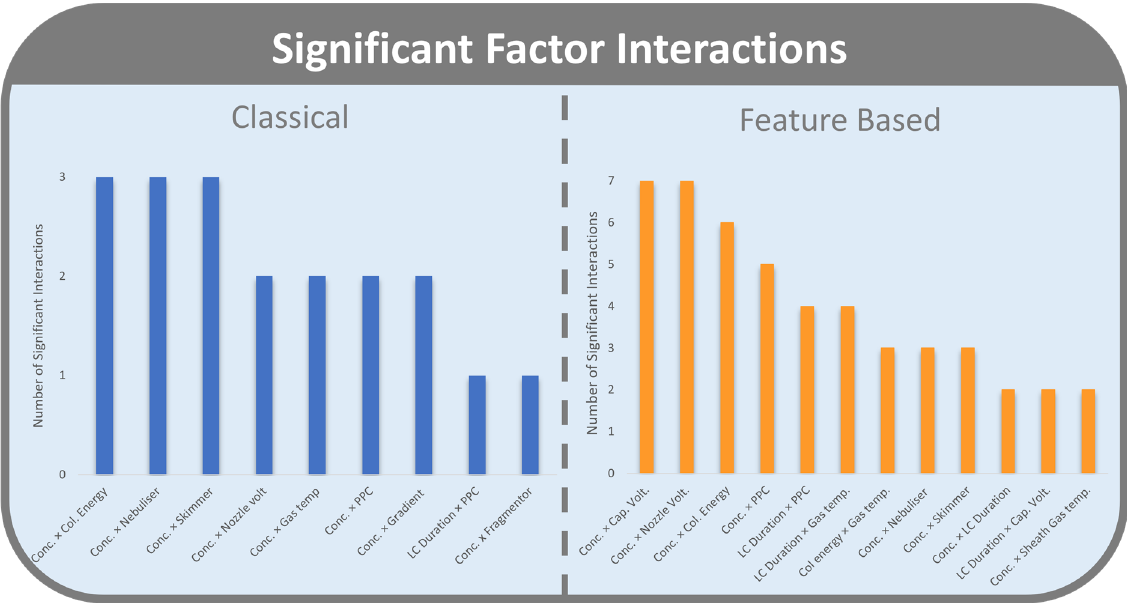
Figure 4. Number of significant factor interactions that affect responses for CLMN (blue, left ) FBMN (orange, right